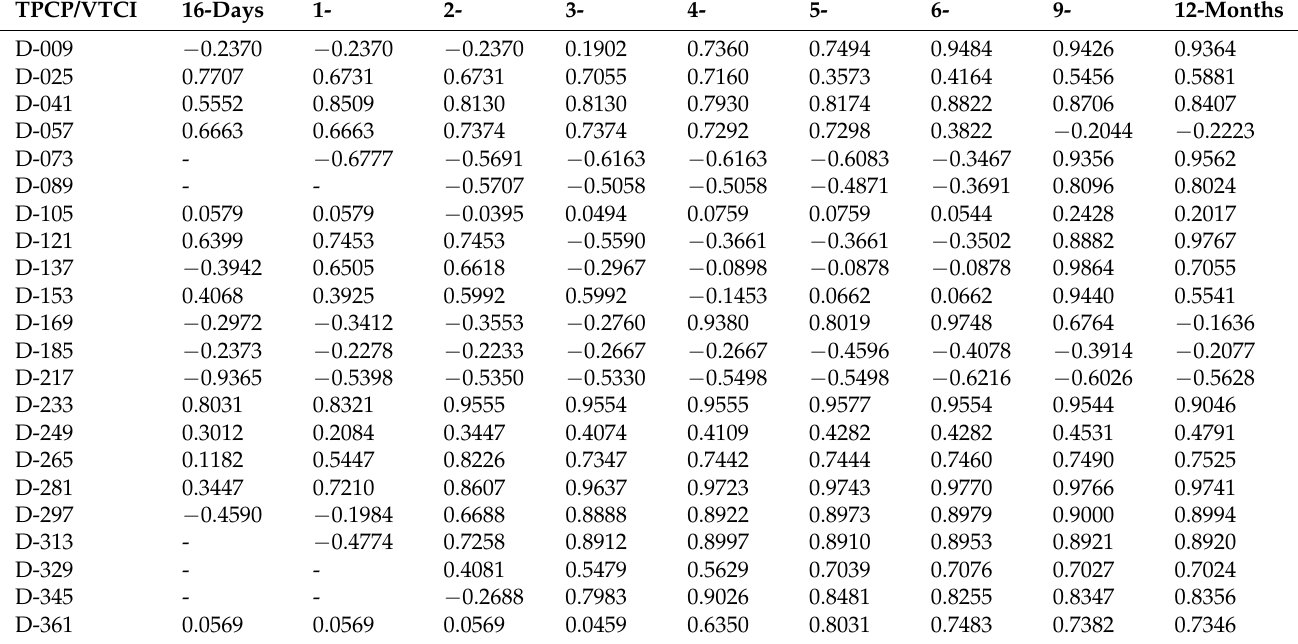
Table 2. The linear correlation coefficients between VTCI imagery from D-009 to D-361 during 2010 and cumulative precipitation anomalies for the 16-day to 12-month periods during 2009–2010.